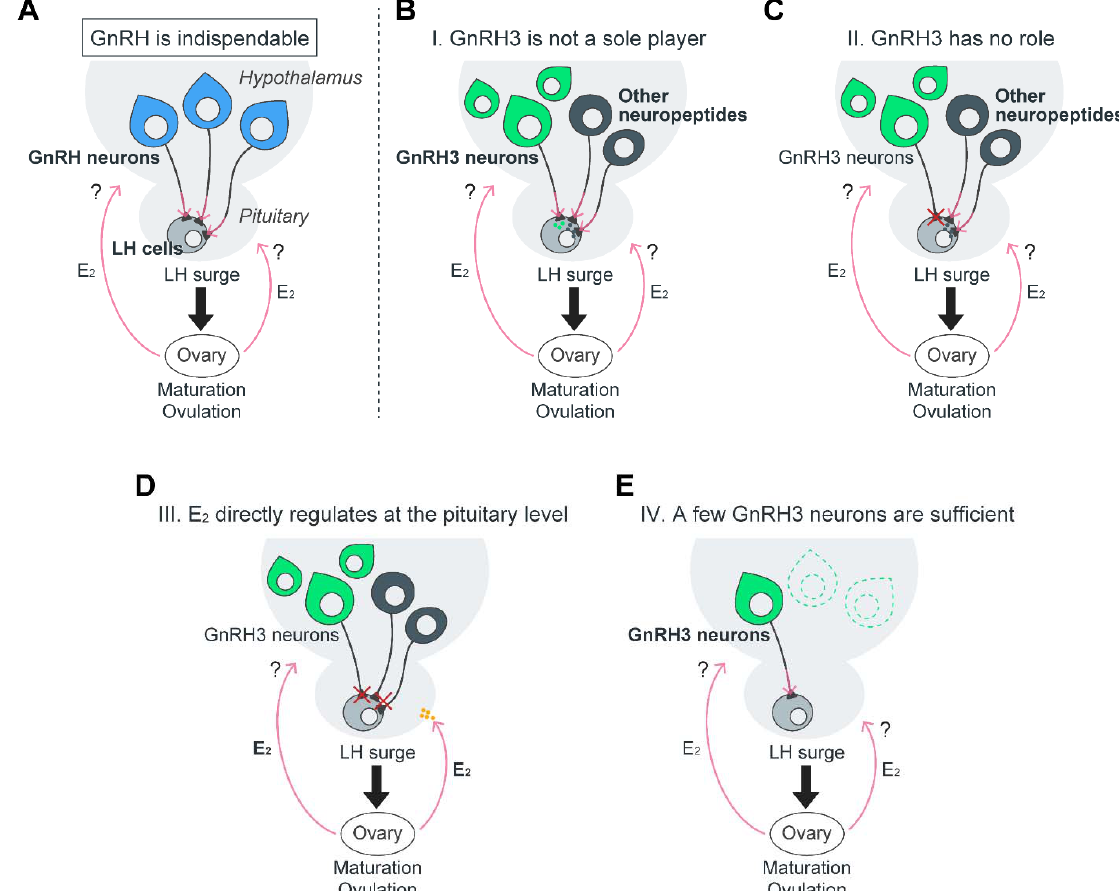
Figure 5. Schematic diagram of the different possible pathways in inducing the pre-ovulatory LH surge along the HPG axis in female zebrafish. In general, the accepted dogma is that the hypophys- iotropic GnRH and its neurons are critical for LH surge, and ultimately oocyte maturation, ovulation, and spawning ( A ). Our current results suggest that GnRH3 neuron-ablated zebrafish females display normal fertility, and previous studies suggest four alternative pathways ( B – E ): I. Hypophysiotropic GnRH3 has no role, but other brain factors (e.g., vasoactive intestinal peptide, kisspeptin, neurokinin B, and secretoneurin) trigger LH surge ( B ); II. Functional redundancy—GnRH3 has a role, but is not the sole and only player, thus sharing this function with other factors ( C ); III. Ovarian estradiol ‐ 17 b (E 2 ) directly induces the LH surge and controls ovulation ( D ); IV. In GnRH3 neuron ‐ ablated females, a few remaining hypophysiotropic GnRH3 neurons are possibly sufficient to elicit LH surge ( E ). The question marks indicate that these pathways remain to be established in zebrafish. 3.1. GnRH1 and GnRH3 Functionally Differ: GnRH3 Likely Functions as a Neuromodulator and Not as an LH Secretagogue Despite the resemblance between GnRH3 and GnRH1 peptides and their neurons, and though the loss of the hypophysiotropic GnRH1 in medaka ( gnrh1 − / − ) results in infer ‐ tility in females [5], gnrh3 − / − zebrafish maintain normal fertility [23,24]. Since the gnrh1 –/– medaka females had fully developed oocytes but failed to ovulate, it can be postulated that GnRH3 in zebrafish, despite being hypophysiotropic, does not play a role in inducing the pre ‐ ovulatory LH secretion. However, our current results contradict the results from the study in which laser ablation of GnRH3 neurons at 4 ‐ and 6 ‐ dpf zebrafish resulted in arrested oocyte development and infertility in female zebrafish [22]. Though these results suggest that GnRH3 and its neurons maintain key roles in reproduction [21,22] (Figure 5A), several alternative scenarios may explain this contradiction. One is that GnRH3 plays an important role only in the development of the reproductive HP axis before puberty